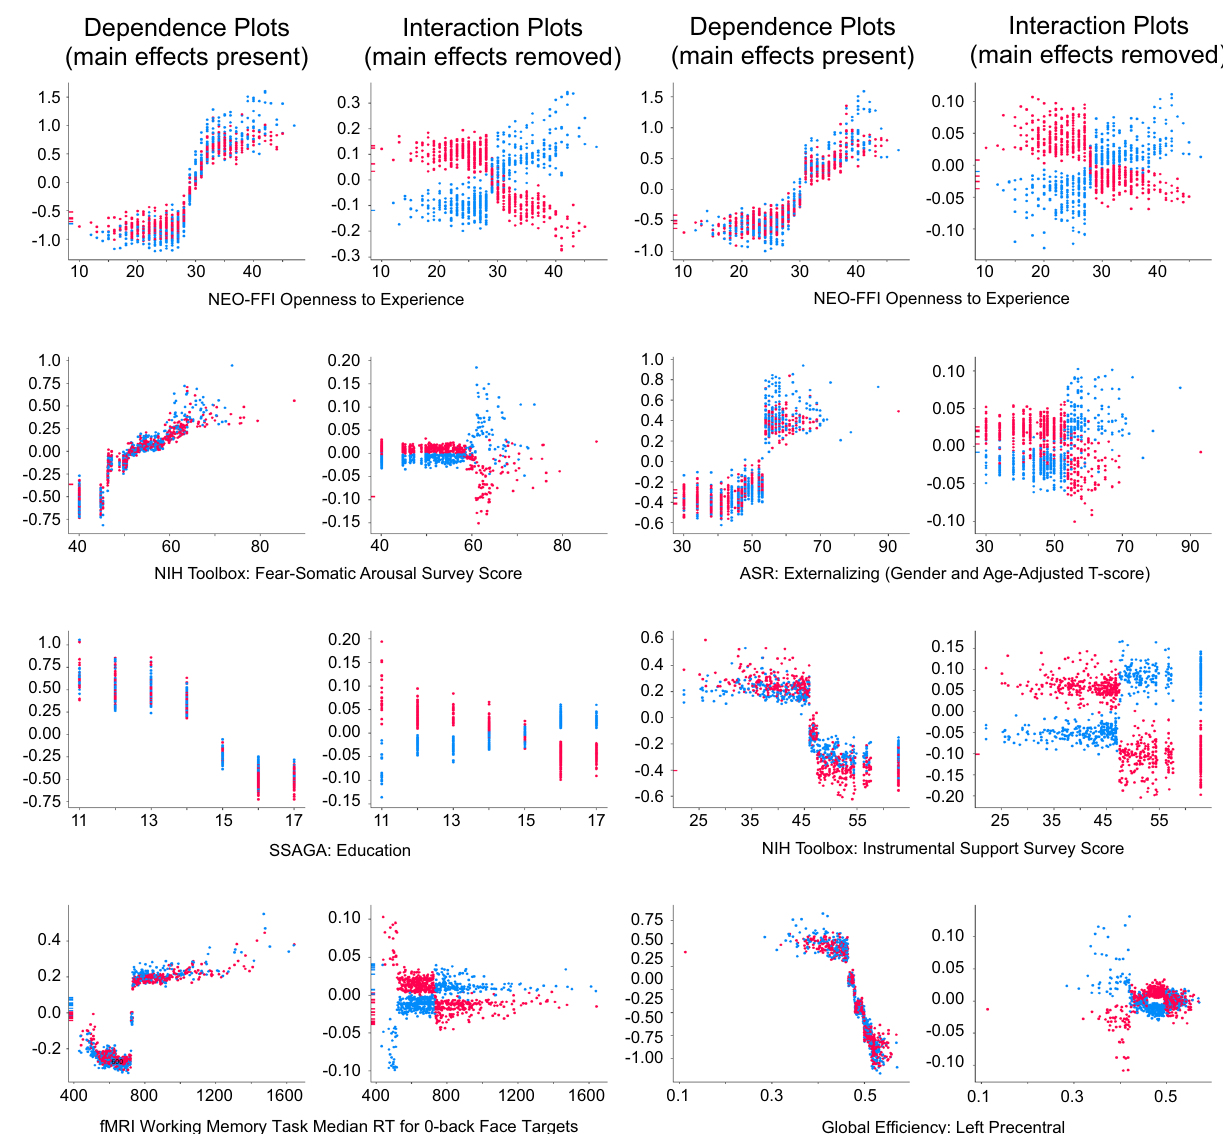
Figure 4. Several factors in the phenotypic + Global Efficiency model classifying cannabis dependence (left) and classifying heavy cannabis use (1000 + uses; right) showed sex/gender interaction effects. As in previous figures, each dot indicates an individual. Dots are colored according to sex/gender (red = women, blue = men). The left columns (“Dependence plots”) show individuals colored according to sex/gender, with main effects intact; the right columns (“Interaction plots”) again show the same individuals, but with main effects removed for improved visualization of sex/gender interaction effects. The x-axis of the plots indicates the observed measurement value of each factor, and the y-axis of each plot indicates the SHAP value (where a higher SHAP value pushed the model closer towards dependence, and lower values pushed the model away from dependence). The magnitude of the SHAP values are standardized in the model and can therefore be interpreted as effect